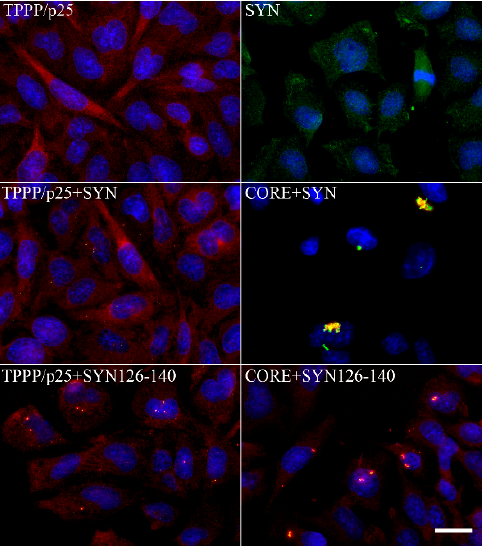
Figure 6. Intracellular aggregates of TPPP / p25 and α -synuclein (SYN) and their truncated forms in CHO10 cells. Uptake of the SYN and / or TPPP / p25 forms from the medium following their premixing as detected by immunofluorescence microscopy: Full length or double truncated (CORE) TPPP / p25 and / or SYN, FITC SYN126–140 (adapted from [111]). Scale bar: 5 μ m.